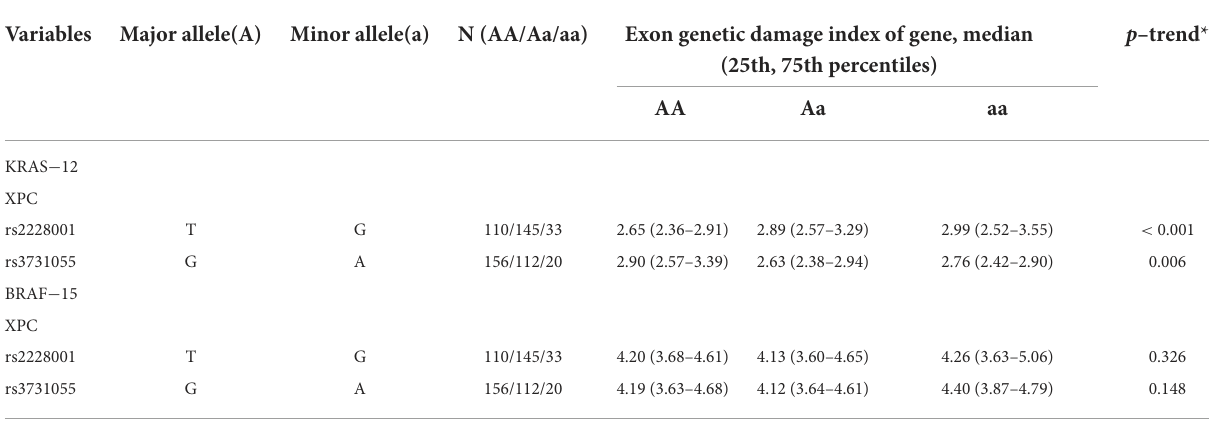
TABLE 3 Exon genetic damage index of gene according to